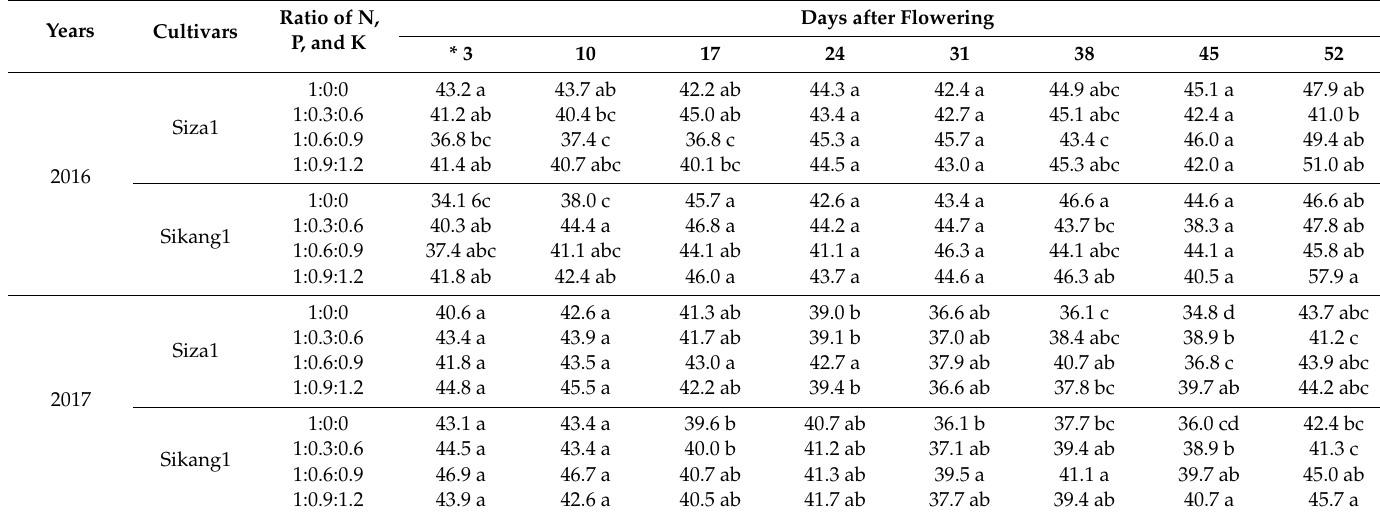
Table 1. E ff ects of the ratio of nitrogen, phosphorous, and potassium application on cotton boll length (mm) of Siza 1 and Sikang 1 during 2016 and 2017.